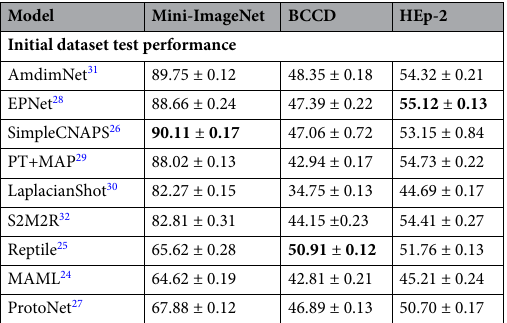
Table 3. Test accuracy results from baseline experiments run against the mini-ImageNet test set, BCCD, and HEp-2. Testing using the BCCD dataset was performed using additional global pooling layers. The highest accuracy relative to each dataset is in bold.